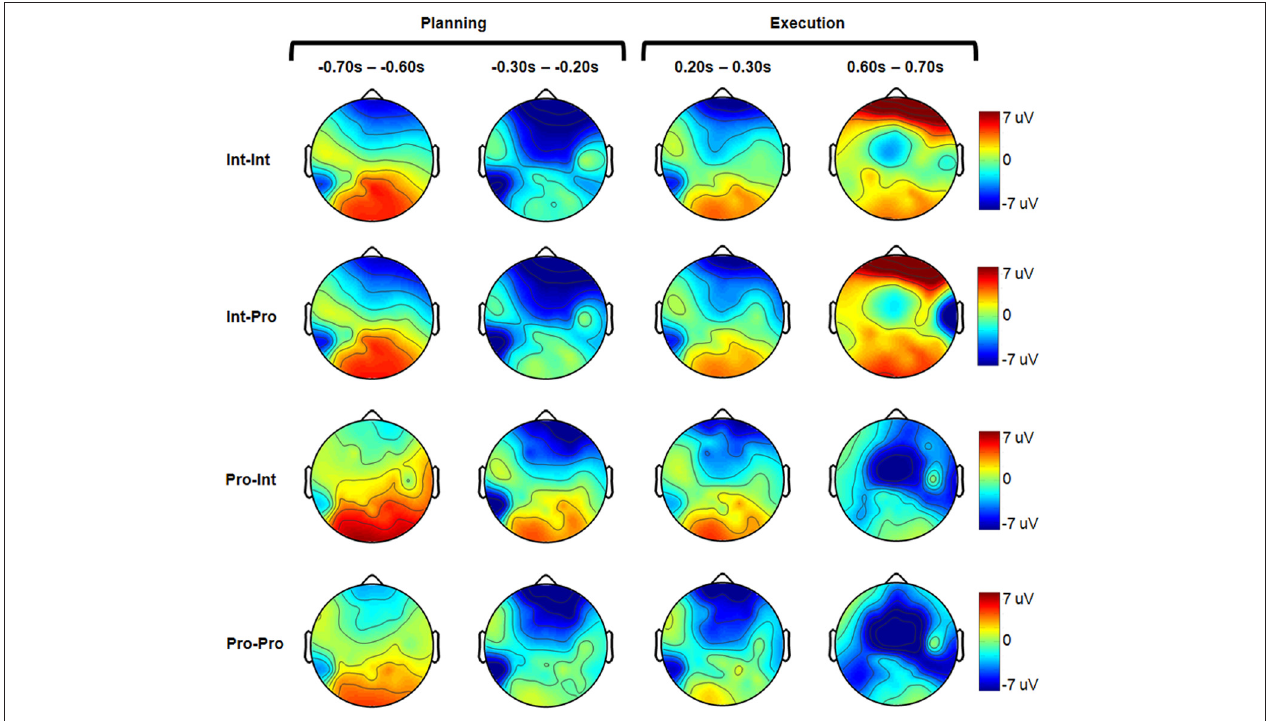
FIGURE 3 | Grand-averaged electrode headplots for all experimental conditions. For each condition, four representative 100ms timebins are shown. The planning and execution phases are marked